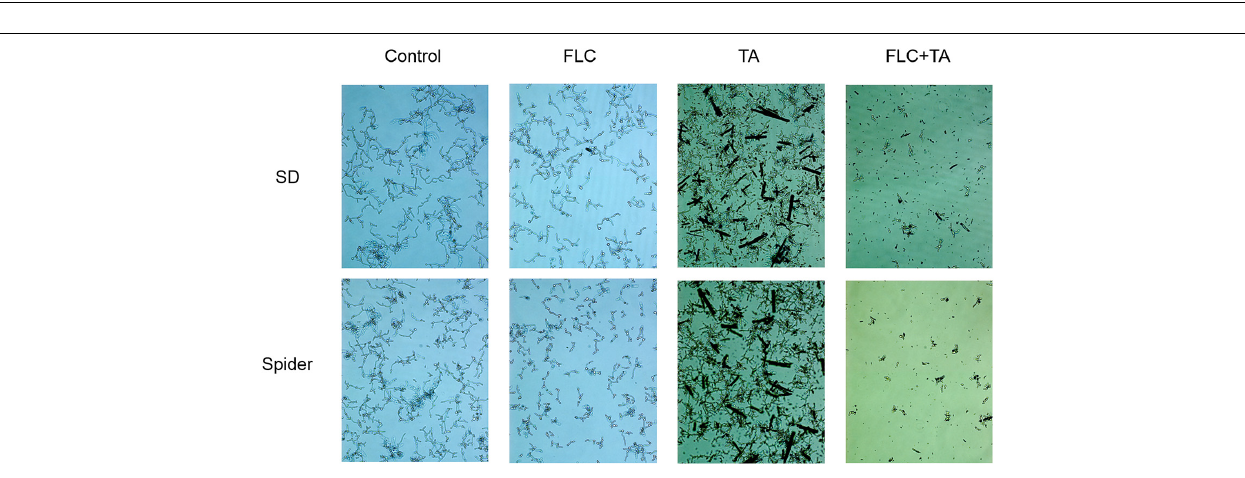
FIGURE 6 | Representative PASM stained section of the kidney. The fungal burden in the kidneys of mice in the combined administration group was significantly reduced (magnification of 400 × ).